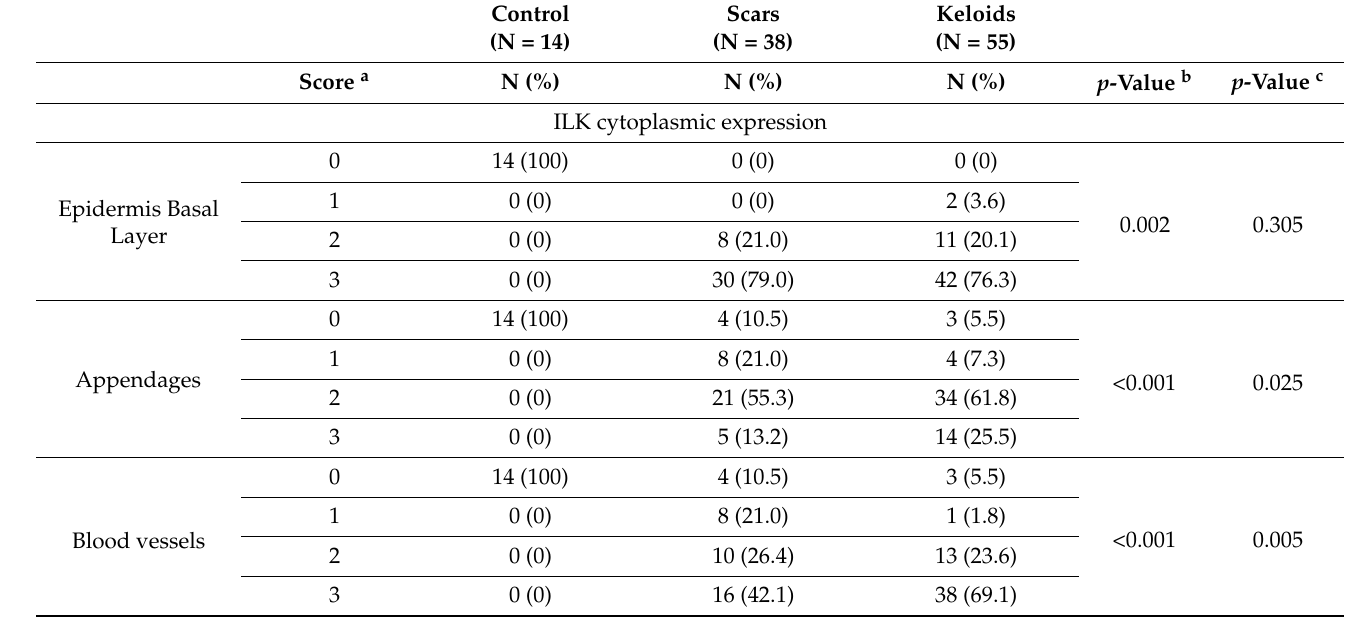
Table 6. Immunohistochemical analysis of ILK expression in control skin, hypertrophic scars and